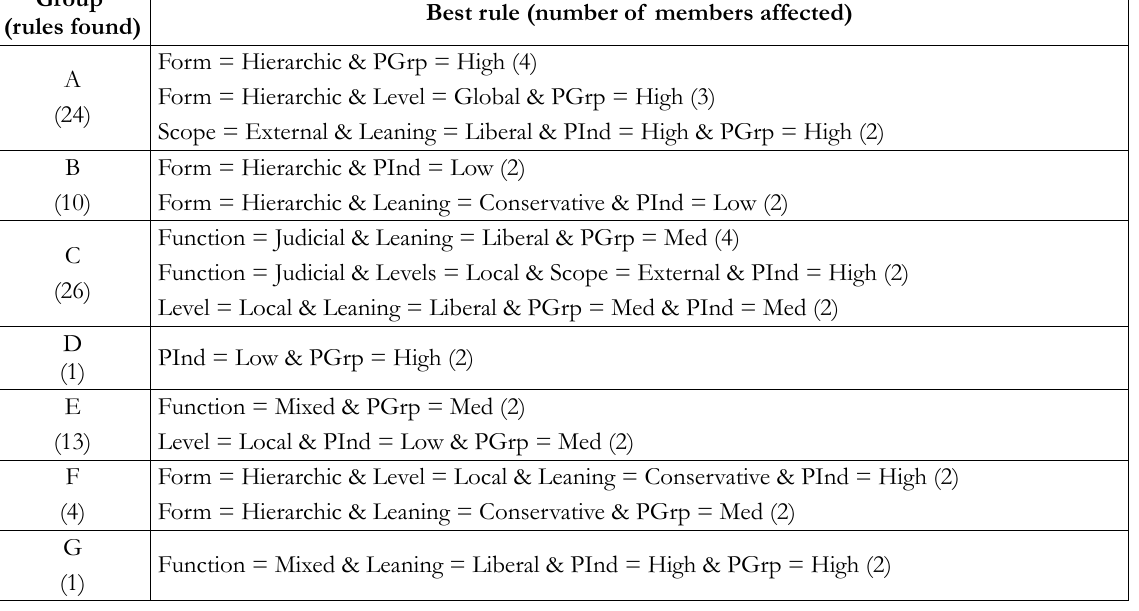
Table 4. Association rules selection in each